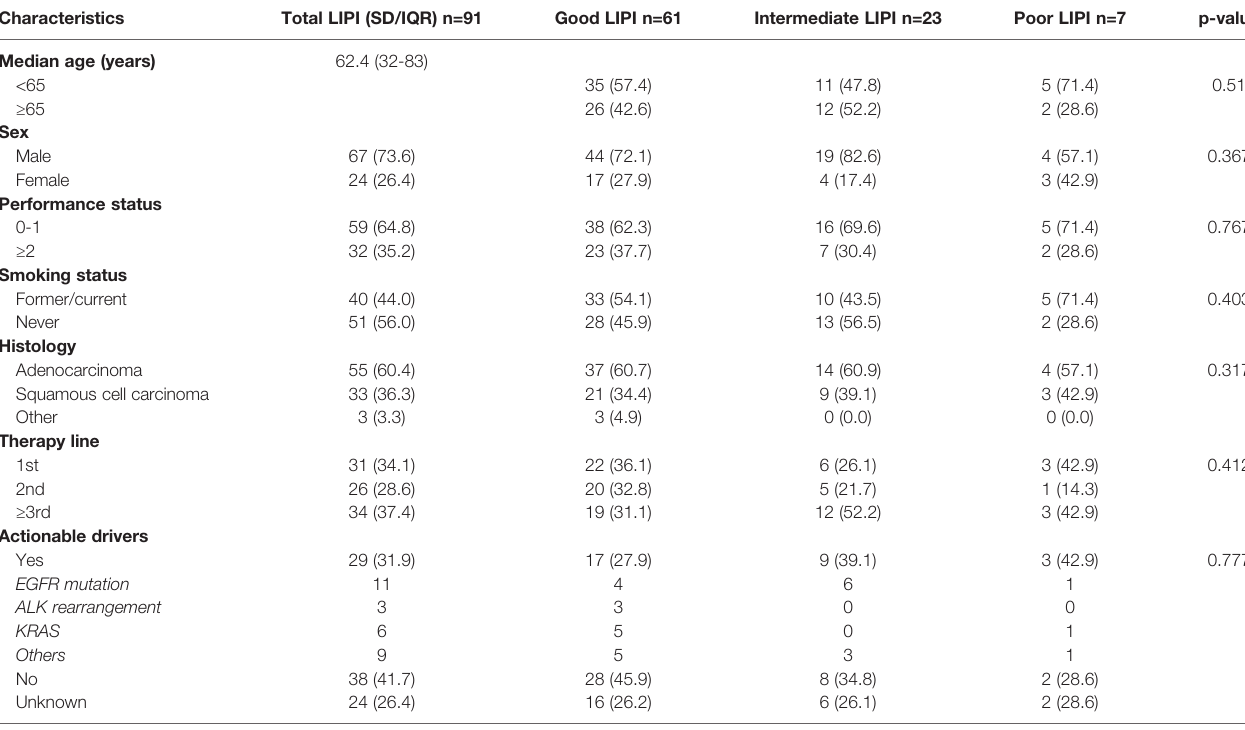
TABLE 1 | Baseline demographic and clinical characteristics of NSCLC patients receiving immunotherapy.